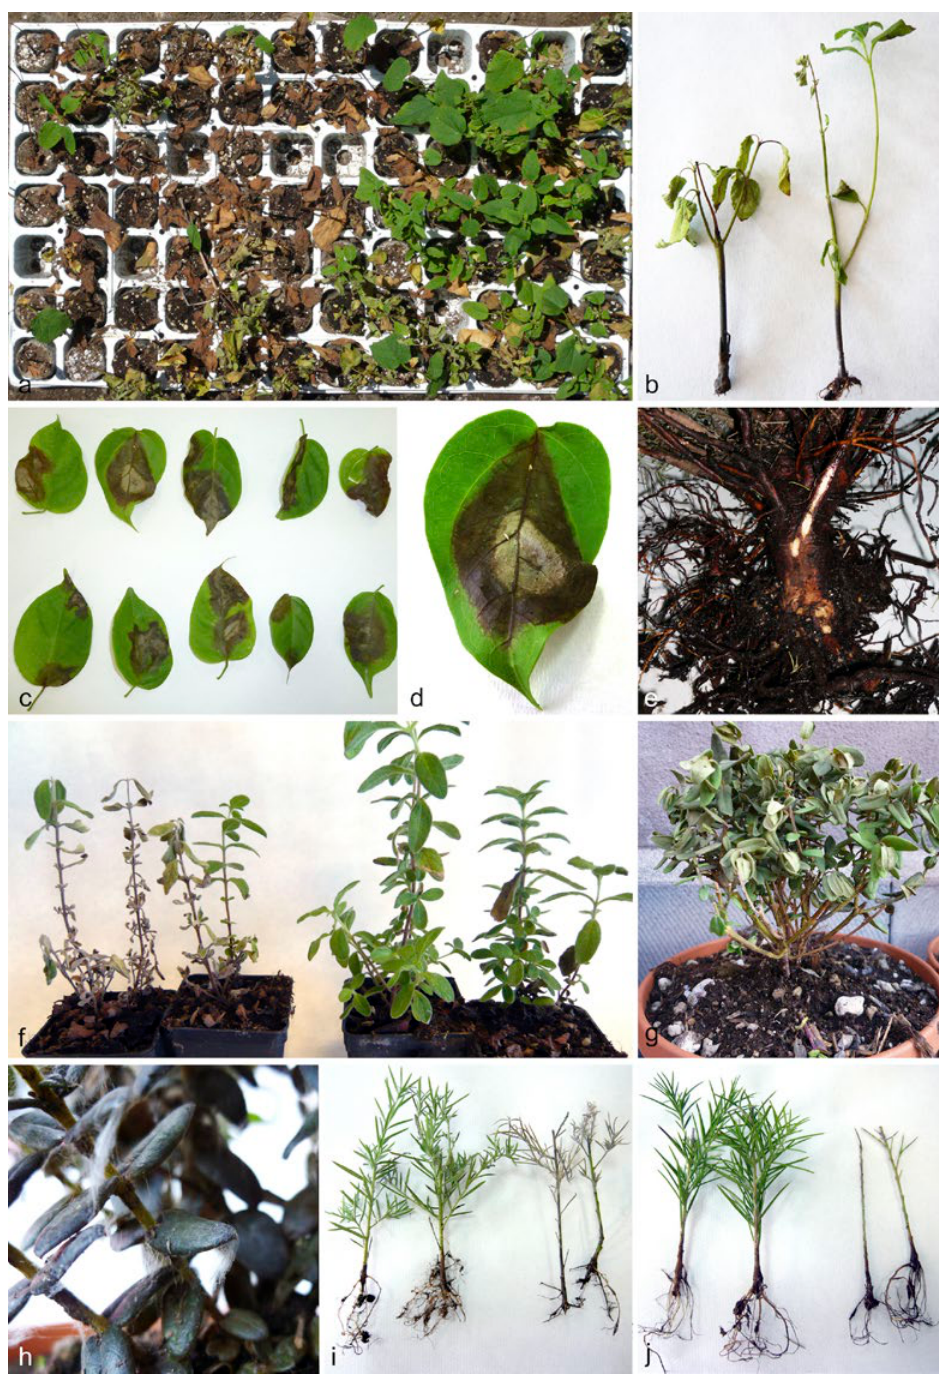
Figure 3. a-e. Natural symptoms caused by Phytophthora spp. a-b, Crown and root rot leading to death of cuttings of Cistus salvifolius . c-d, Leaf lesion symptoms on Bignonia venusta . e, Crown and root rot on Grevillea juniperina ‘CVE’. f-j, Symptoms caused by Phytophthora spp. after artificial inoculation. f, Inoculated C . creticus plants compared with healthy plants. g-h, Foliar blight of Polygala myrtifolia × oppositifolia . i-j, Un-inoculated compared with symptomatic cuttings of Grevillea gracilis (i) and G . juniperina